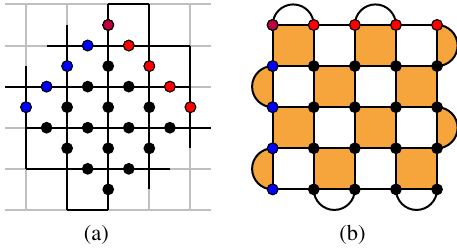
FIG. 4. (a) Rotated 5 × 5 surface code defined by drawing the boundary at 45° relative to the surface code lattice. Logical operators are given by a product of X along the northeast edge and Z along the northwest edge. As with the standard code, stabilizer generators consist of X ( Z ) operators on edges around vertices (plaquettes). (b) Rotated 5 × 5 surface code as it is usually, and equivalently, depicted, where shaded (blank) faces corresponding to X -type ( Z -type) stabilizer